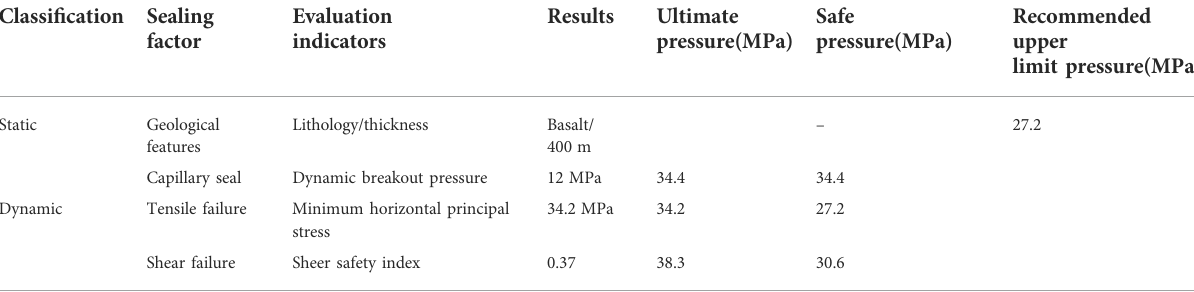
TABLE 5 M UGS geological body pressure bearing capacity evaluation